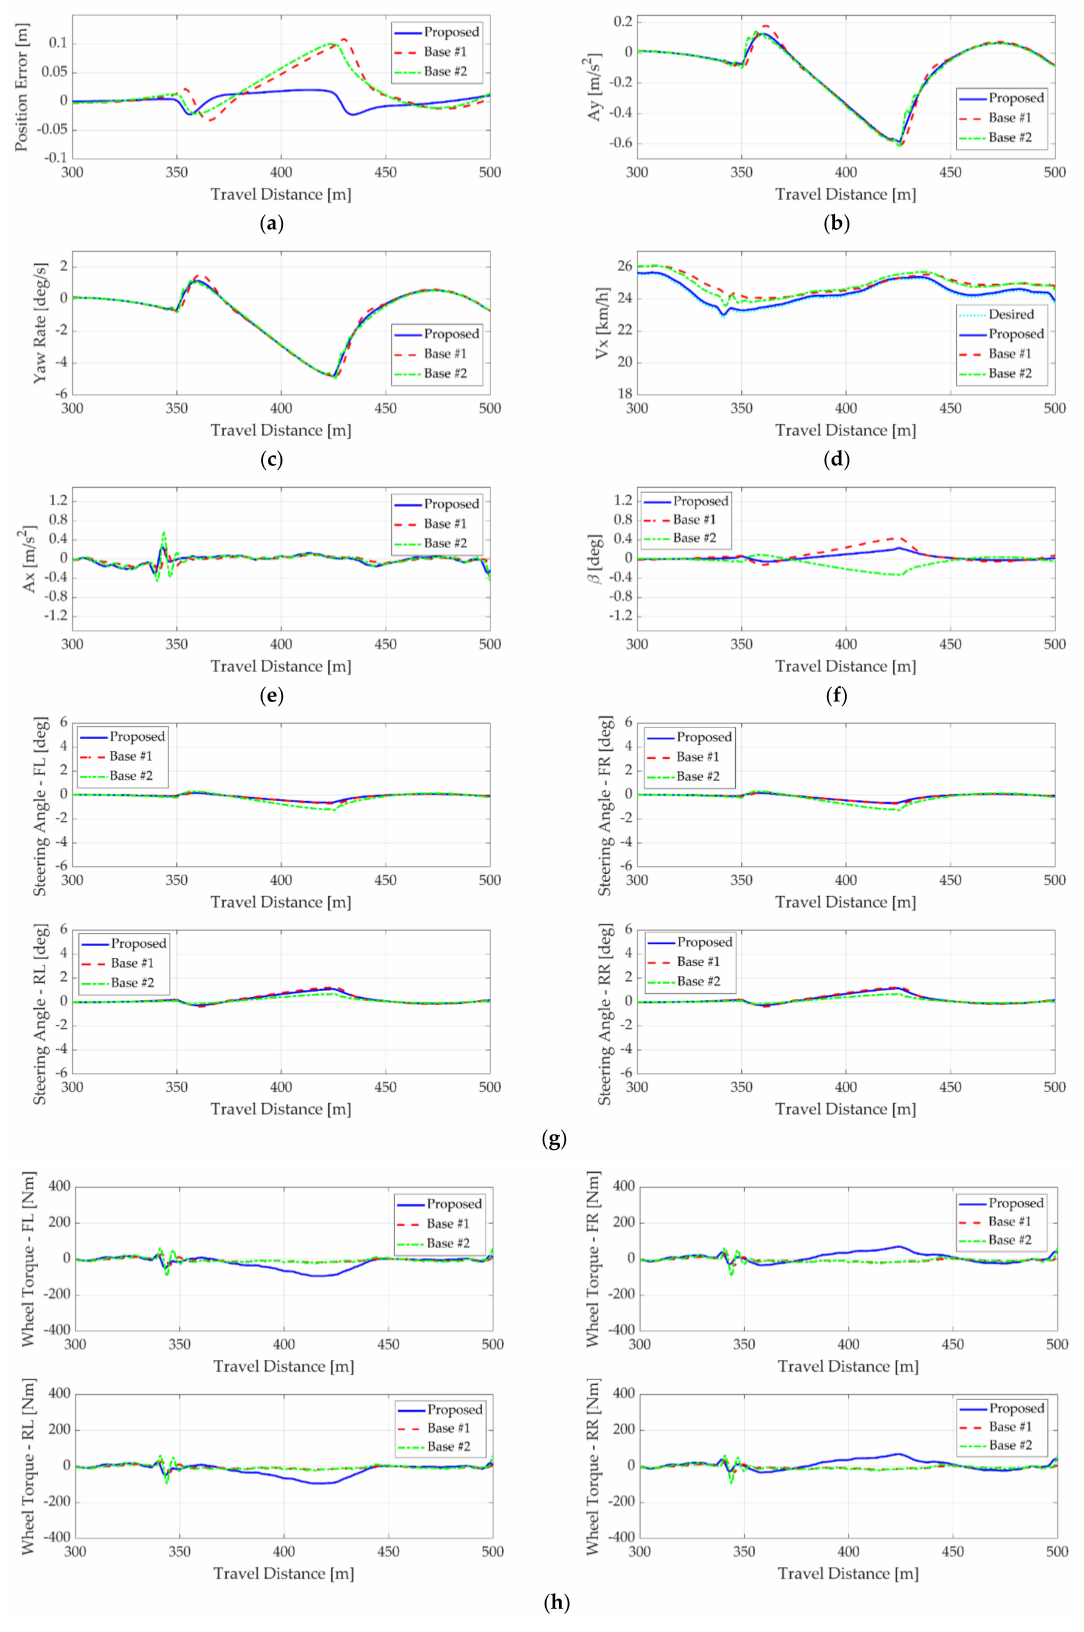
Figure 7. Simulation results of Case #1: ( a ) position error; ( b ) lateral acceleration; ( c ) yaw rate; ( d ) longitudinal velocity; ( e ) longitudinal acceleration; ( f ) body slip angle; ( g ) steering angle; ( h ) wheel